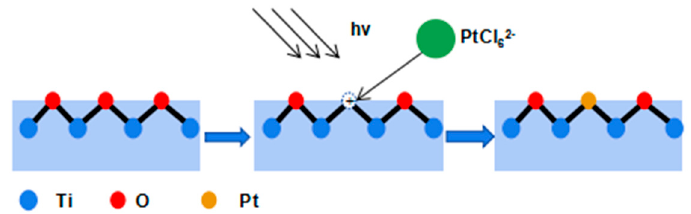
Figure 6. ( a ) Full Raman spectra; ( b ) locally magnified Raman spectra (100–200 cm − 1 ) of the used Pt/TiO 2 and TiO 2 samples via three different Pt sources.